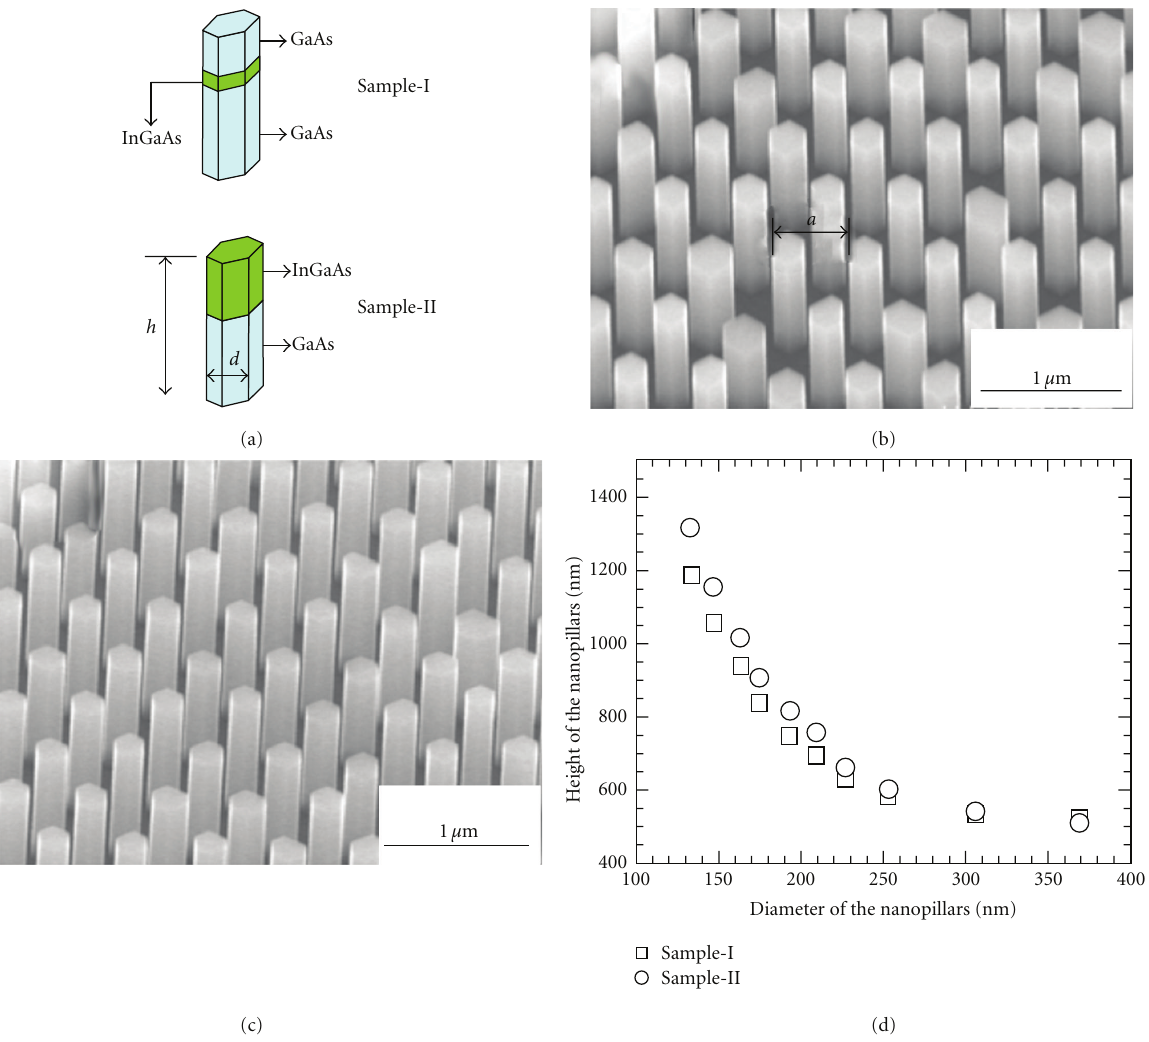
Figure 2: Structures of nanowire samples and SEM images of grown nanowires. (a) Schematics of structures for samples I and II. The nanowire diameter is defined by d . (b) SEM image for sample I. The nanowire pitch is defined by a . (c) SEM image for sample II. (d) Dependence of heights of samples I and II on their diameters